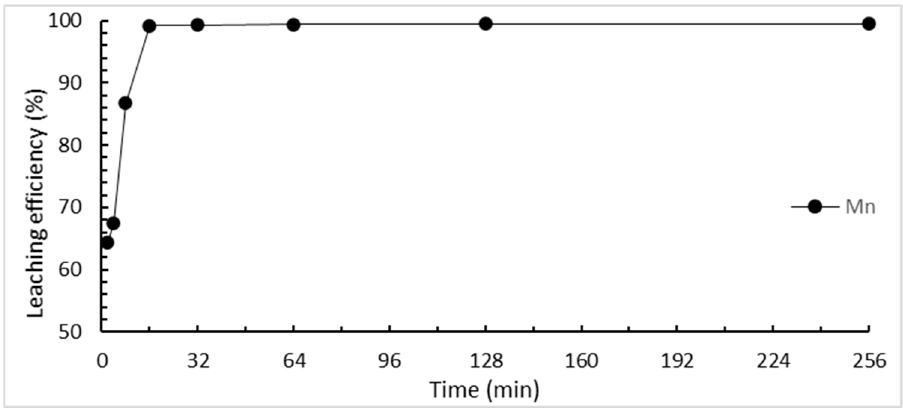
Figure 6. Effect of reaction time on the selective leaching efficiency. (HCl concentration: 3 M; L/S ratio: 40 mL/g; reaction temperature: 25 °C).